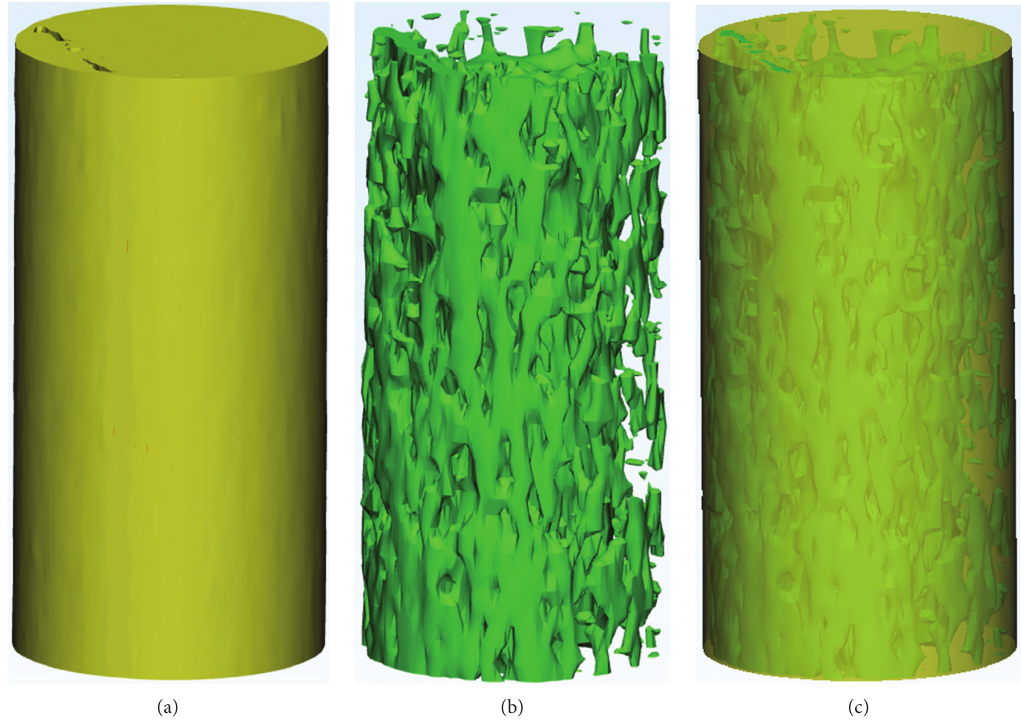
Figure 8: Three-dimensional mesoscopic model of the acid-corroded sandstone. (a) Corroded area. (b) Uncorroded area. (c) Rock sample as a